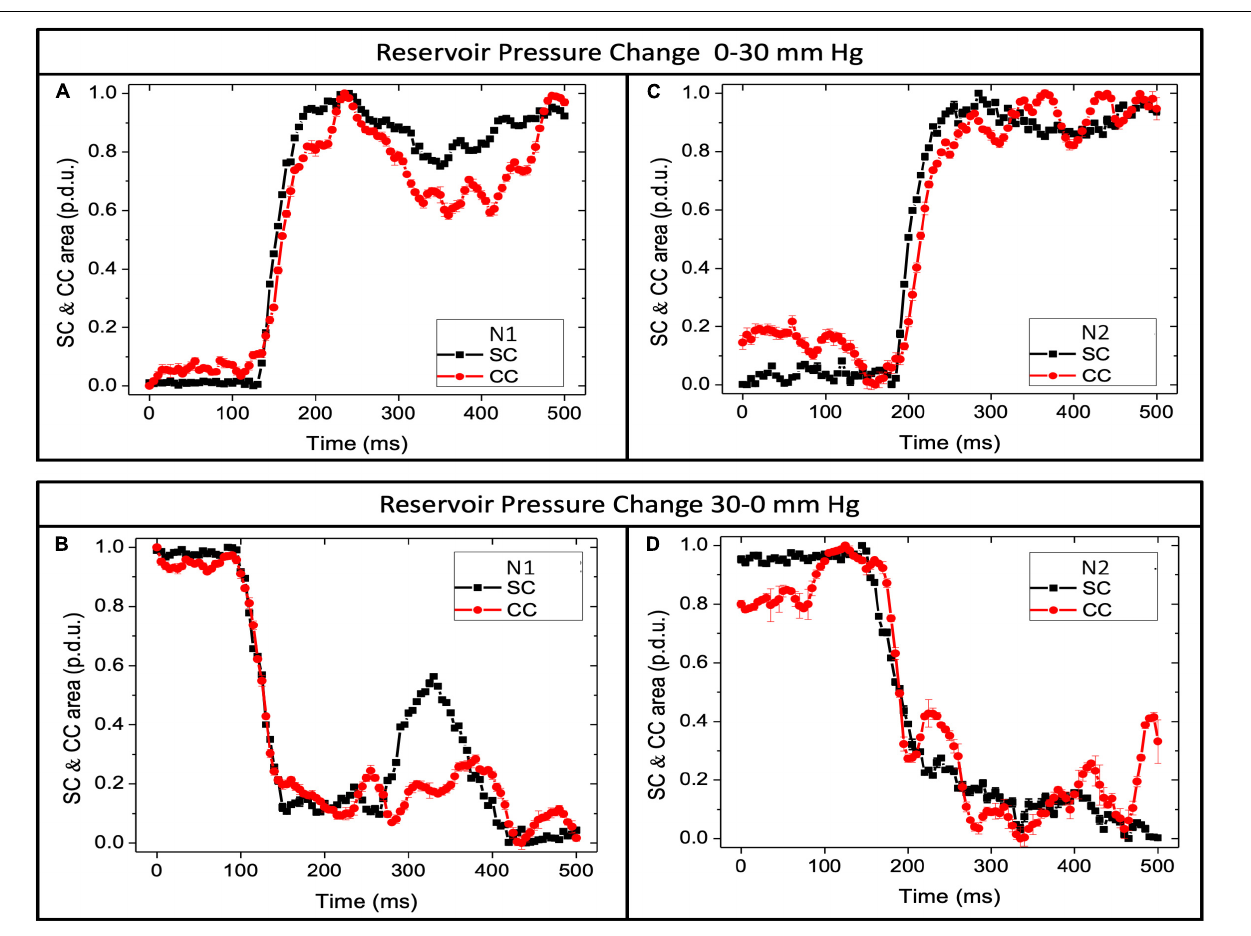
FIGURE 7 | Schlemm’s canal and collector channels respond with pressure changes. Normal eye pressure responses. (A,C) SC area (SCA) and CC area (CCA) vs. time when reservoir pressure increases from 0 to 30 mm Hg. (B,D) SCA and CCA area when pressure decreases from 30 to 0 mm Hg. Y-axis is normalized data using the maximum area as the reference dimension. In both graphs, “p.d.u.” or procedure-defined dimensionless units define the area. The time to the first peak or trough was < 200 ms. Oscillations after pressure changes were more pronounced when the pressure dropped from 30 to 0 mm Hg. SCA changes reflect trabecular meshwork mechanical properties, while CCA dimension changes reflect mechanical properties of collagenous structures at CC entrances. N is the subject’s eye. Supplementary Figure 2 documents synchronous motion of SCA and CCA at 3 locations in normal and 3 in glaucoma